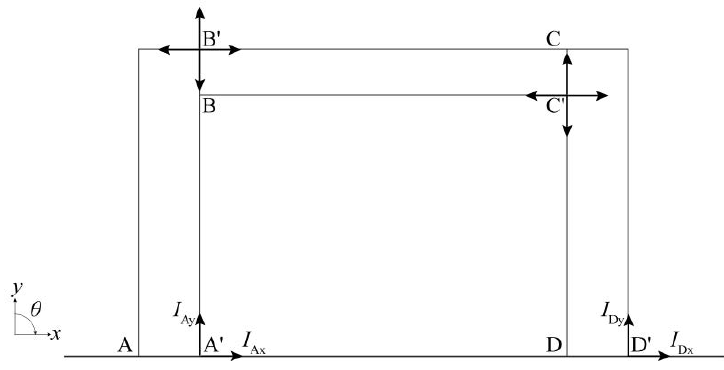
Figure 6. Collision energy dissipation of PCRF for θ 1 <